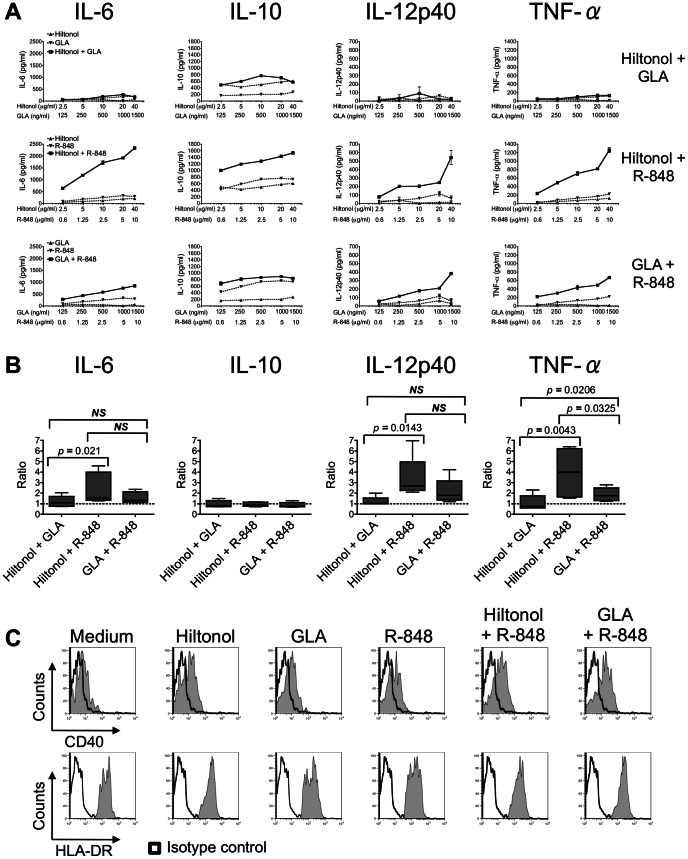
Selected TLR ligand combinations potently induce cytokine secretion by CD14+ DDCs.(A) Cytokine production after stimulation of CD14+ DDCs for 48 h with a range of concentrations (horizontal axes) of Hiltonol, GLA and R-848, or with combinations of these TLR ligands. The data are presented as means ± SEM of duplicates from one representative donor out of four independent experiments in which all 3 TLR combinations were tested at the same time. (B) Validation of potential synergistic effects of three TLR ligand combinations on cytokine expression. The ratio of the highest cytokine response elicited by the combined stimuli over the sum of the responses for the two individual agents at their constituent concentrations was calculated. A ratio >1 is indicative of synergy,  = 1 of additivity (displayed on charts as dashed lines), and <1 of antagonism. The data are presented as means ± SEM from 4–6 donors. (C) Phenotypic analysis of CD14+ DDCs stimulated with TLR ligand combinations. The expression of CD40 and HLA-DR was measured after 48 h. Black open histograms represent the isotype controls. One experiment representative of three is shown.